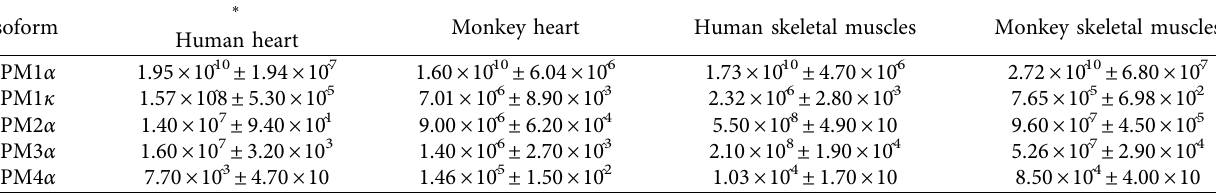
Table 2: Expression of transcripts of various sarcomeric TPMs in heart and skeletal muscles in human and nonhuman primate. Isoform